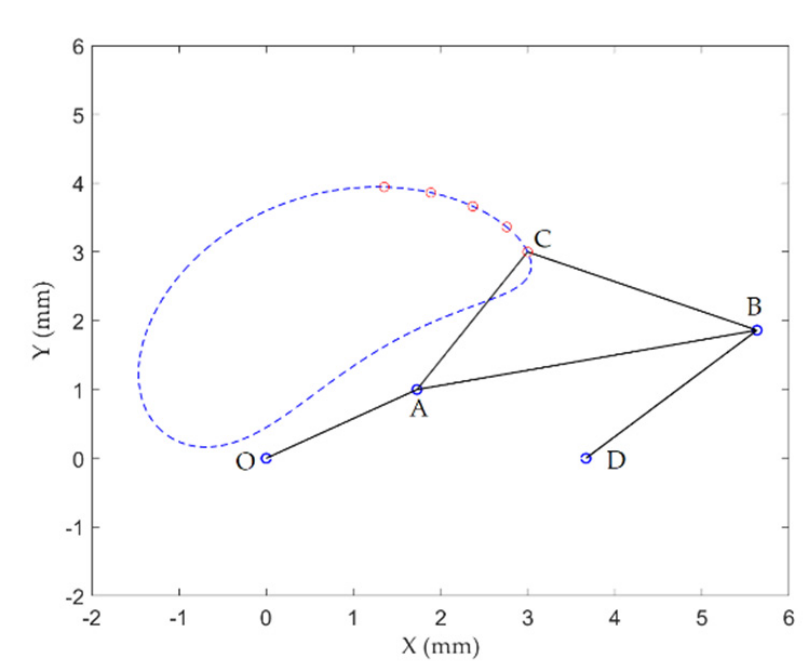
Figure 8. Trajectories of the coupler point of Case 1.